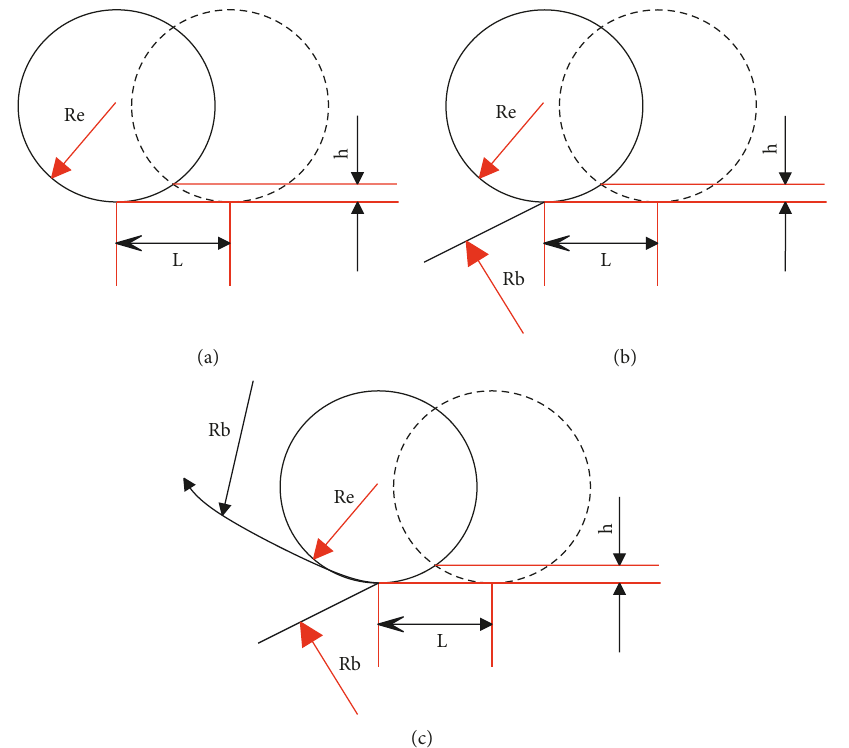
Figure 2: Residual height of equal residual height method. (a) Plane machining. (b) Convex Surface Machining. (c) Concave surface